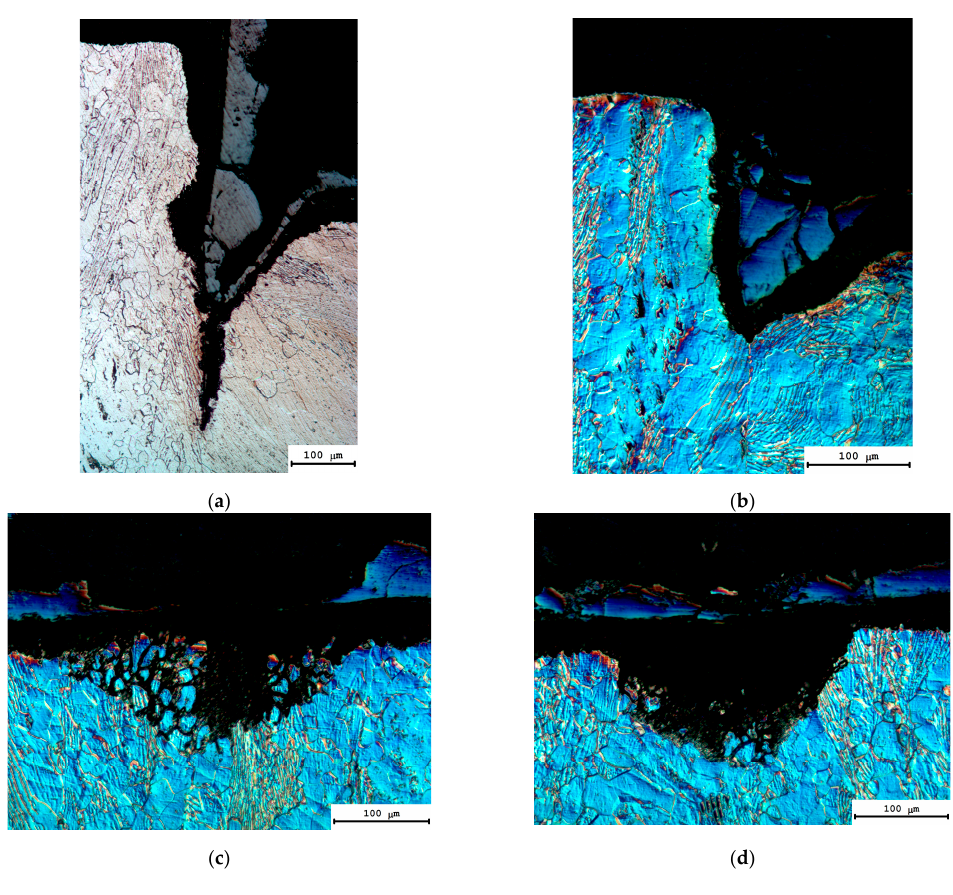
Figure 11. Results of XRD analysis of the salt contaminations on the surfaces of coarse-grained ( a , b ) and UFG ( c , d ) specimens after HSC testing: ( a , c ) V h = 50 °C/min, T = 600 °C, t = 10 min, P = 50 MPa;